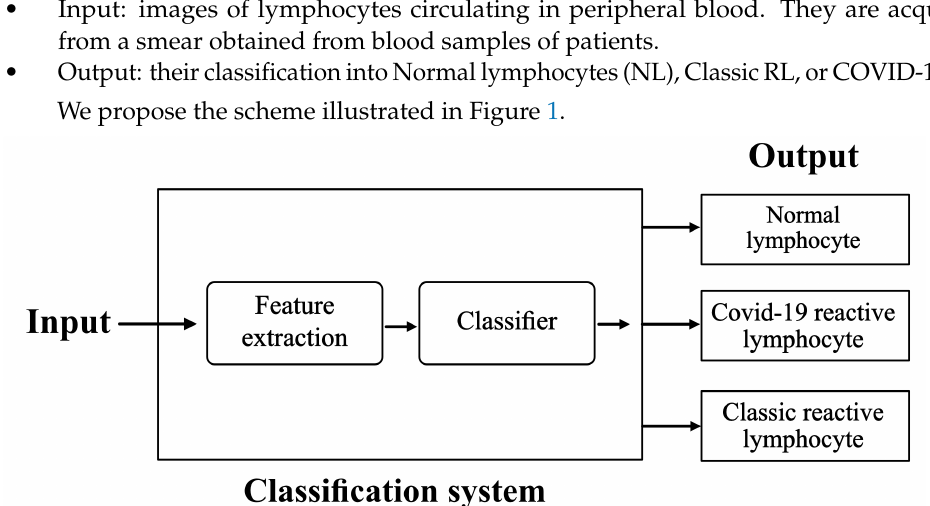
Figure 1. Classification system. The inputs are digital images of lymphocytes obtained from a fresh sample of the patient’s blood. The system includes a convolutional architecture for the extraction of quantitative features and a classifier to distinguish input cells as normal lymphocytes, COVID-19 RL, or Classic